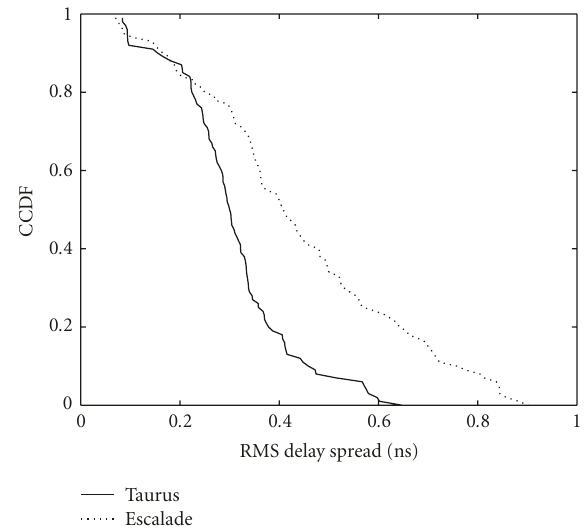
Figure 9: CCDF of the RMS delay spread for UWB propagation beneath the chassis.